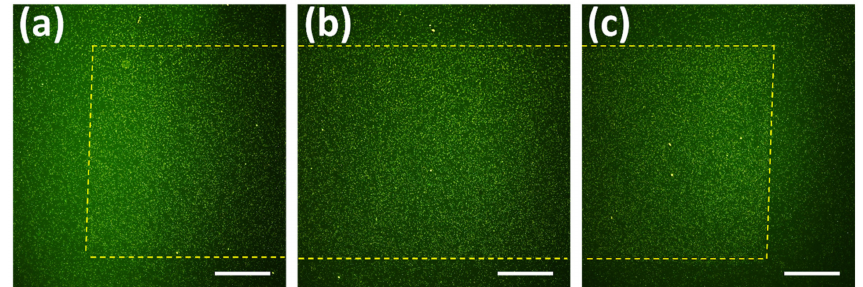
Figure 3. Fluorescent images of E. coli-WT after 5 min adhesion to di ff erent surface coverages at 10 × magnification: ( a ) Low Coverage, ( b ) Medium Coverage, ( c ) High Coverage. The yellow dash marks the edges of the nanopattern. Green is bacteria. Scale bars = 250 µ m.